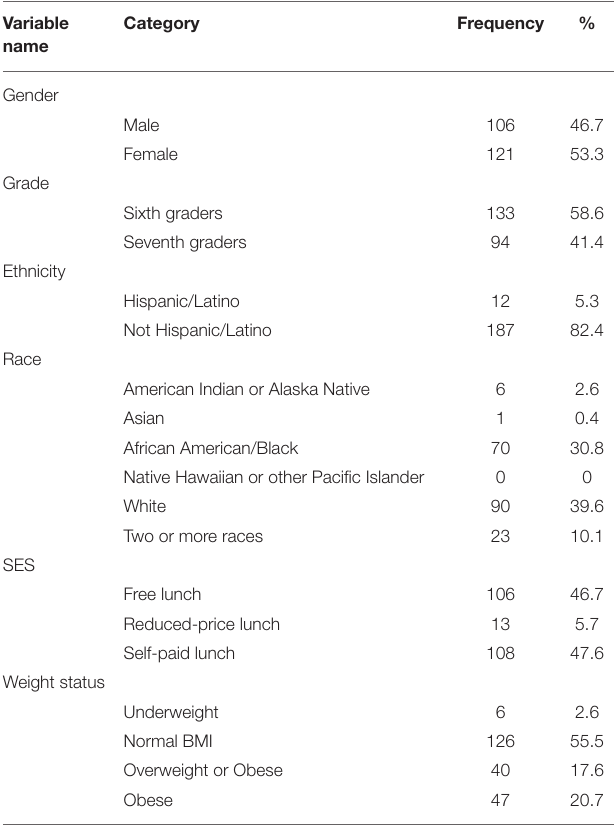
TABLE 1 | Characteristics of the